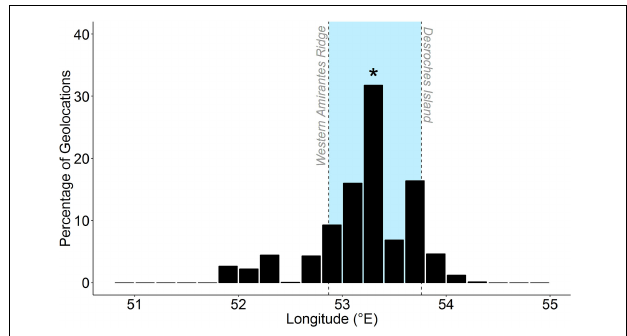
FIGURE 4 | Percentage of longitude estimates among five geo-located satellite tracks of reef manta rays ( Mobula alfredi ) in Seychelles. Blue shading represents longitudinal range of the Amirantes Group. Asterisk represents longitude at tagging location (D’Arros